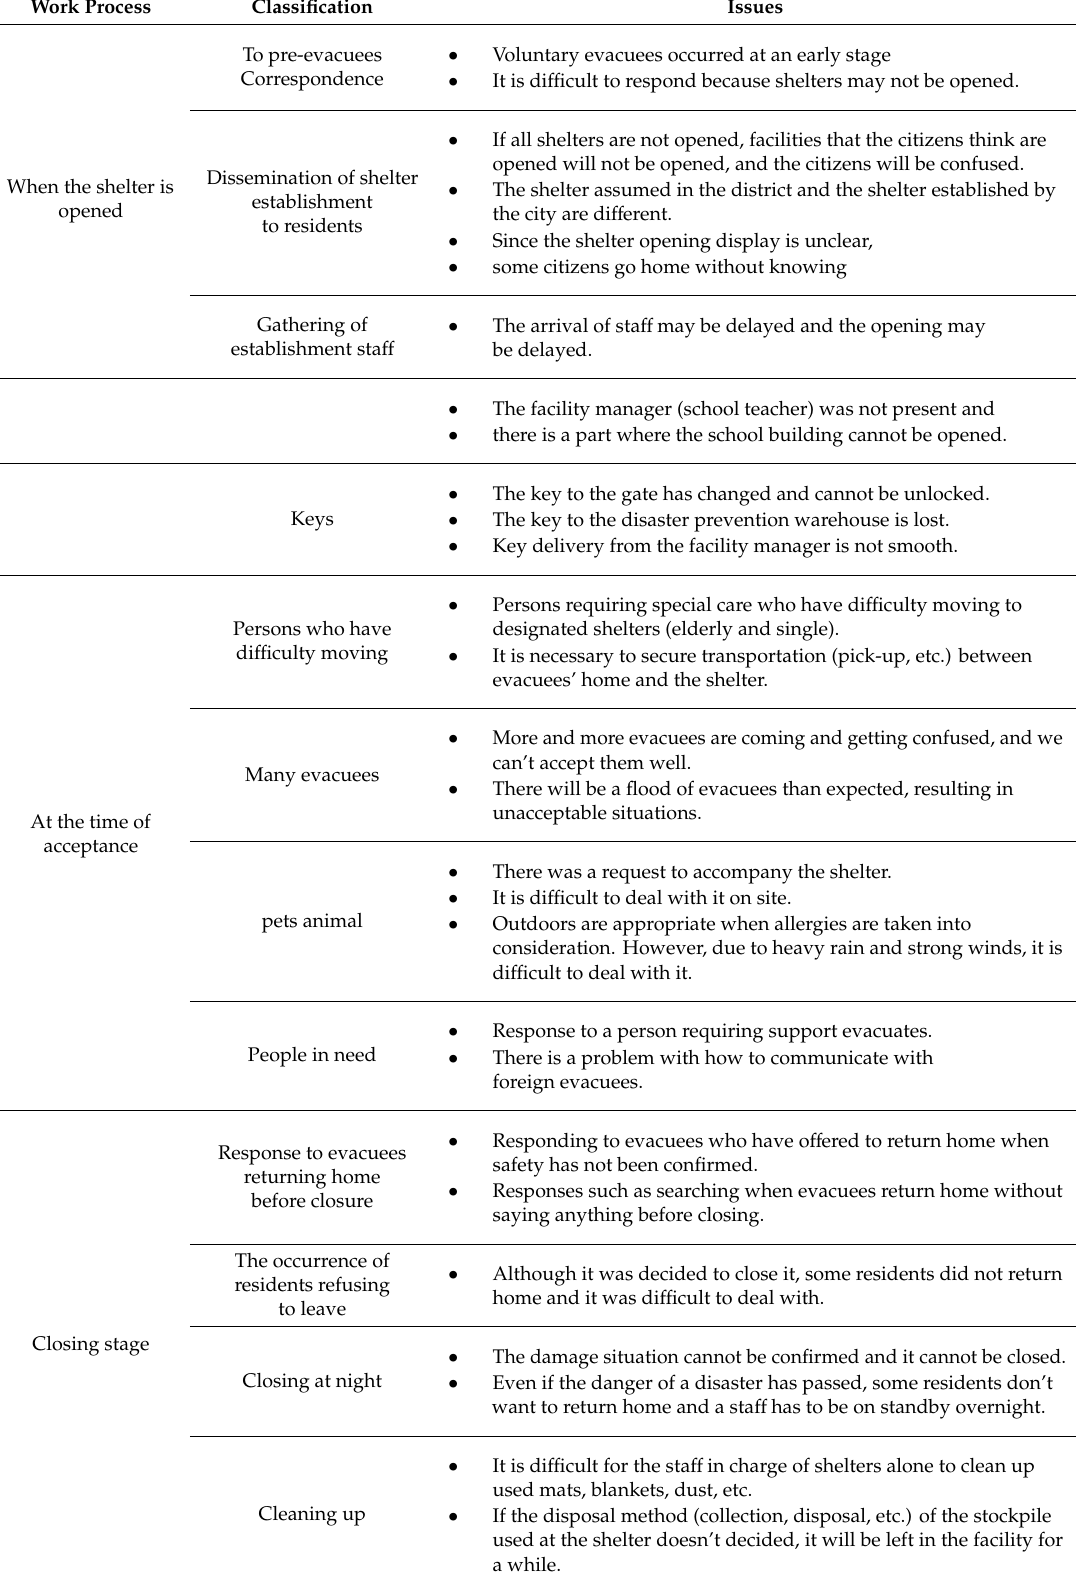
Table 3. Issues related to shelter